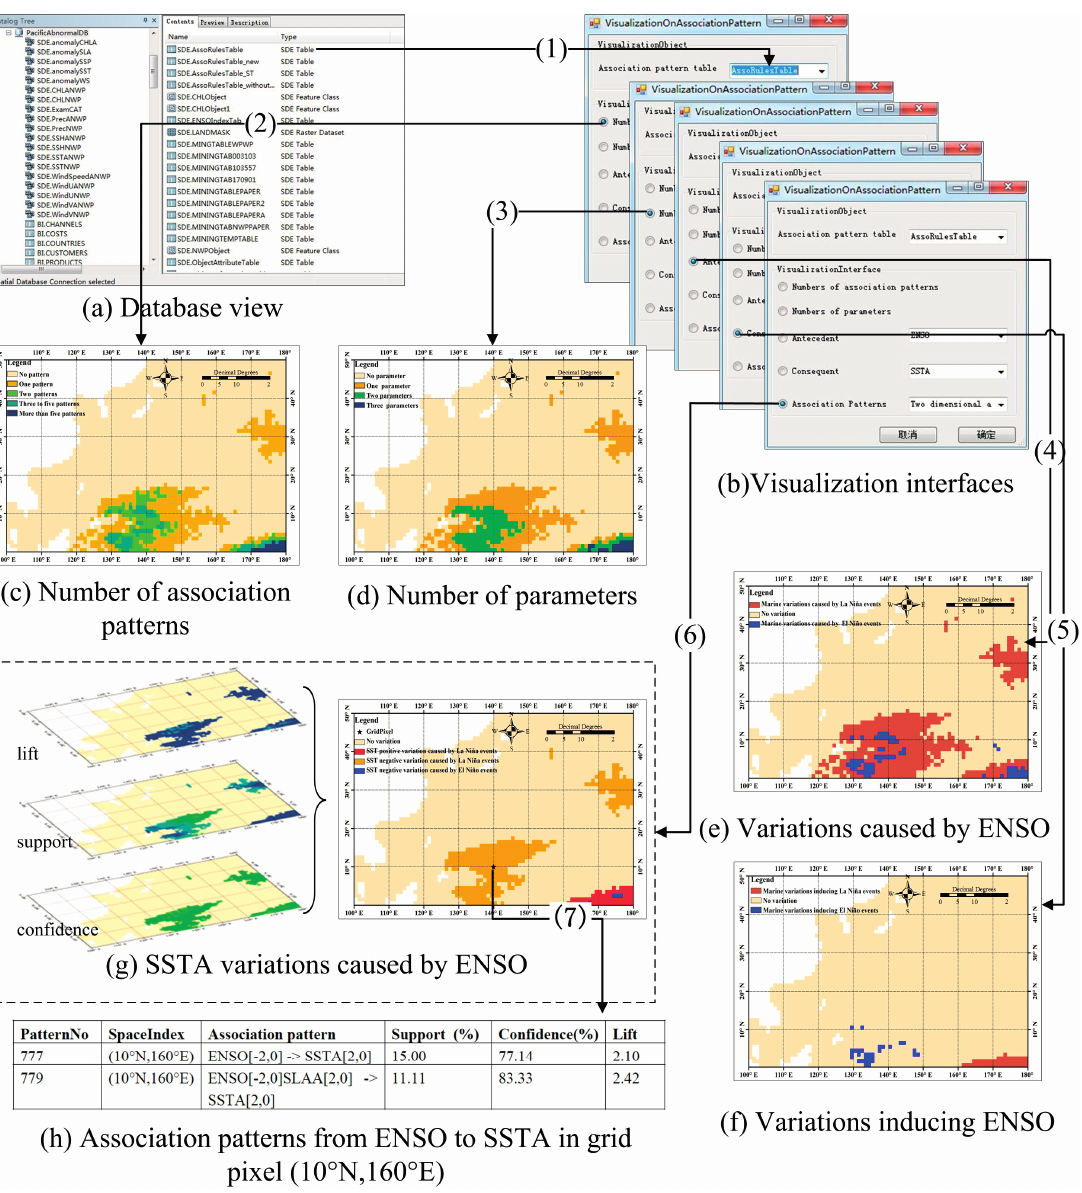
Figure 6. The visualization process from database to final views at various scales: ( a ) Database storing image datasets, object datasets, and table datasets. ( b ) Series of interactive interfaces linking the database and visualization views. ( c ) Spatial distribution of a number of association patterns showing which areas are interactive and which are not. ( d ) Spatial distribution of a number of parameters showing which marine parameters are associated, or not, and where they are associated. ( e ) Variations caused by antecedents ( i.e. , ENSO) showing the spatial distribution of marine variations caused by other marine parameters. ( f ) Variations inducing consequents ( i.e. , ENSO) showing the spatial distribution of marine variations that induce other marine parameters. ( g ) Association patterns between two marine parameters (ENSO → SSTA) showing the detailed association characteristics between them with a series of evaluation indicators (support, confidence, and lift). ( h ) Detailed association characteristics for a specified grid pixel (10°N,